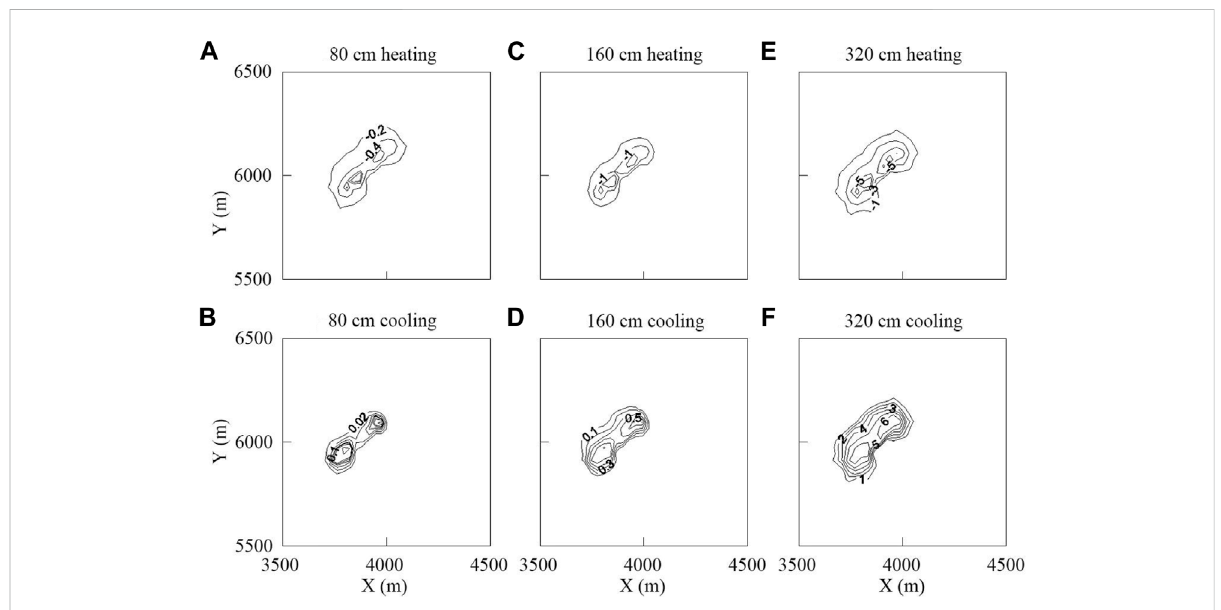
FIGURE 9 Temperature change contour map ofburied depth atthe end ofheatingperiod and cooling period, (A) and (B) are atthe -80 cm depth, (C) and (D) are at the -160 cm depth, (E) and (F) are at the -320 cm